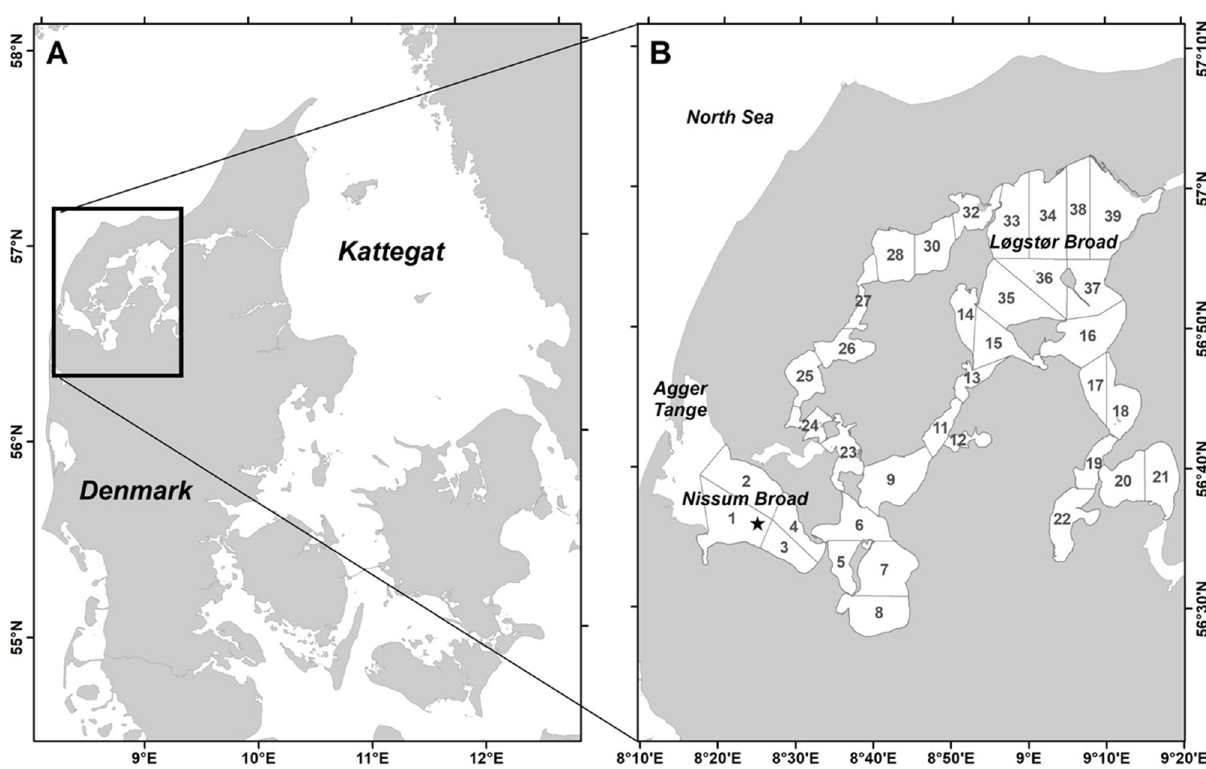
Fig. 1. (A) Location of the Limfjorden, Denmark. (B) The surveyed areas included in the annual stock surveys in the Western part of the Limfjorden, where numbers refers to shell fi sh production areas and ★ =temperature monitoring